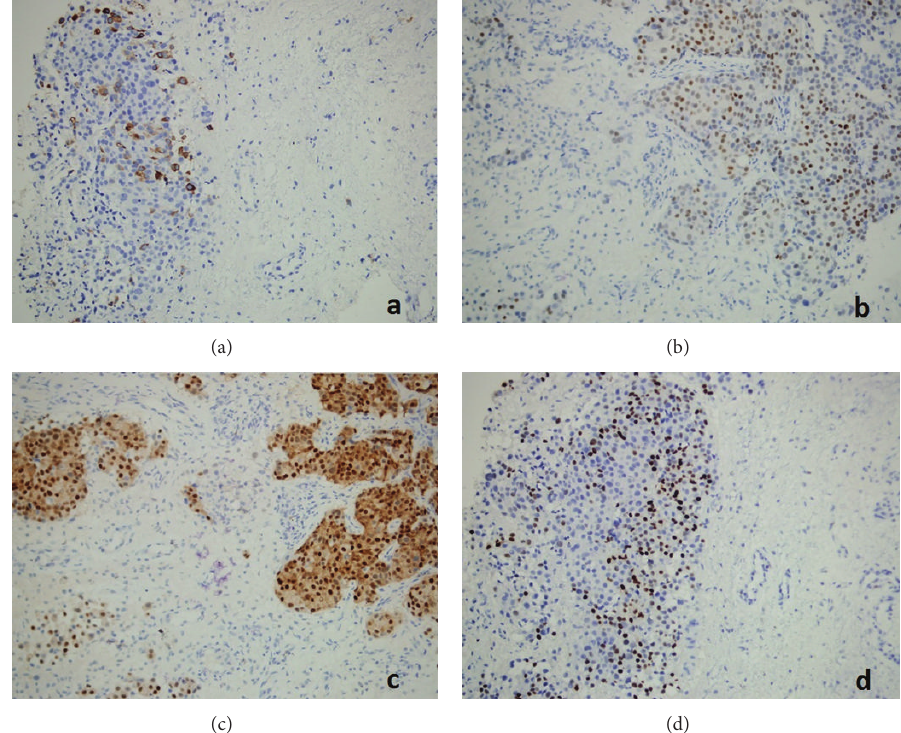
Figure 5: (a) Mammaglobin expression of tumor cells ( × 200), (b) estrogen receptor status of tumor cells ( × 200), (c) androgen receptor status of tumor cells ( × 200), and (d) progesterone receptor status of tumor cells ( ×